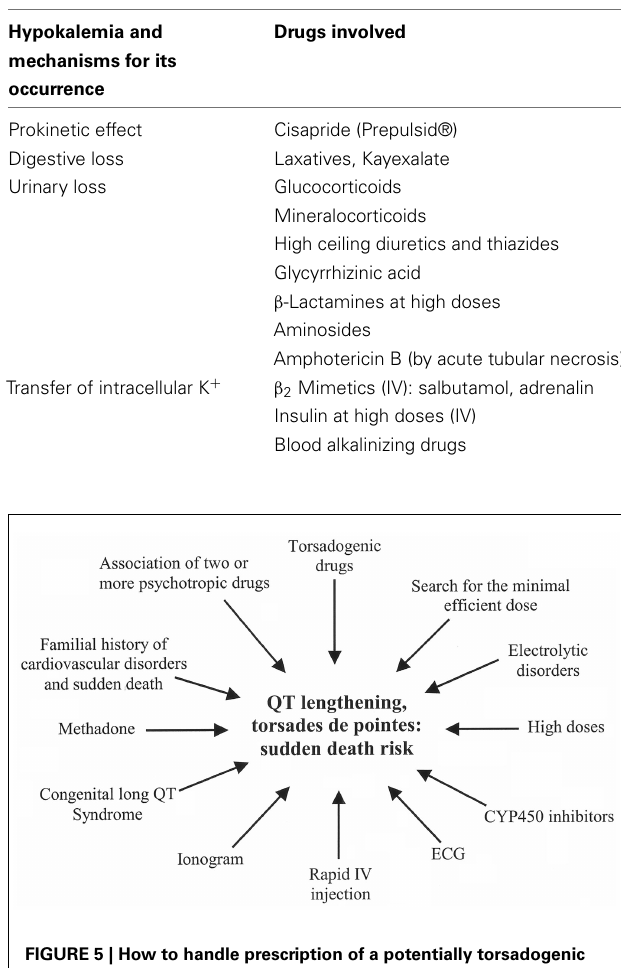
increase the risk of TDP. It is therefore recommended to